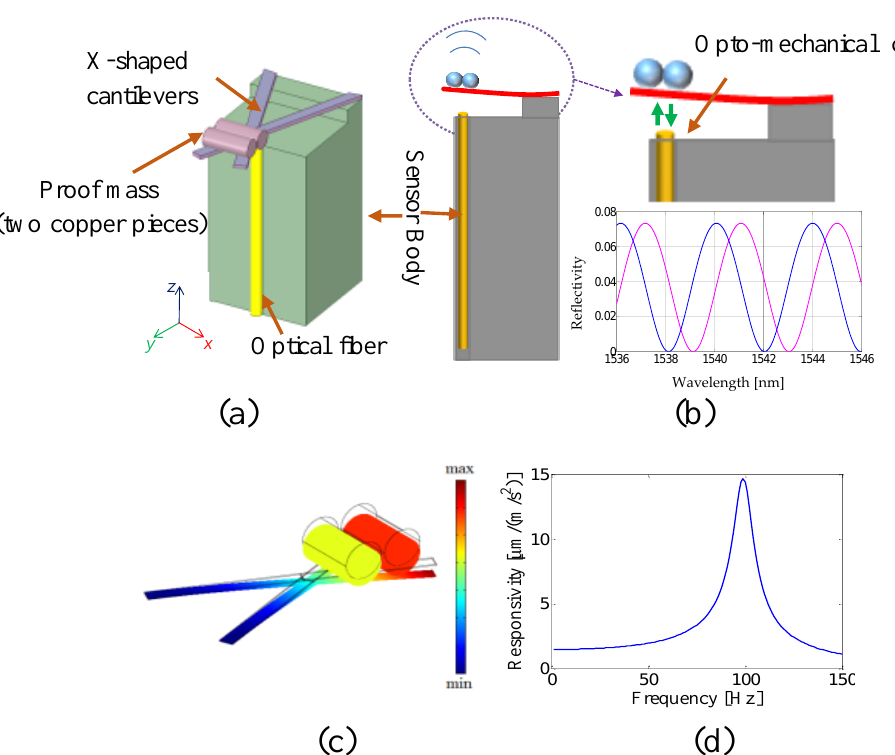
Figure 13. ( a ) Schematic and ( b ) principle of operation of the Lab on fiber seismic sensor. Inset: Schematic picture of the cantilever deflection due to a ground vibration. The Fabry-Pérot air cavity changes due to the effect of cantilever deflection and an interferometer phase shift occurs in the reflectance spectrum. Exemplificative reflection spectrum of the seismic sensor before (blue line) and after deflection (magenta line). ( c ) “Deformed shape” representation of the total displacement when the structure is subject to a vertical acceleration at 5 Hz. ( d ) amplitude of the numerical responsivity of the OF sensor. Reproduced with permission from ref [70] (the figure is released under a CC-BY-SA license http://creativecommons.org/licenses/by/4.0/ (accessed on 12 March 2023)).